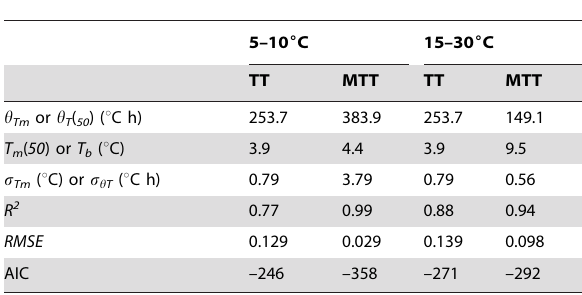
Table 1. Comparison between the thermal time (TT) and the modified thermal time (MTT) model in describing germination of control seeds (0 day of storage) at various suboptimal